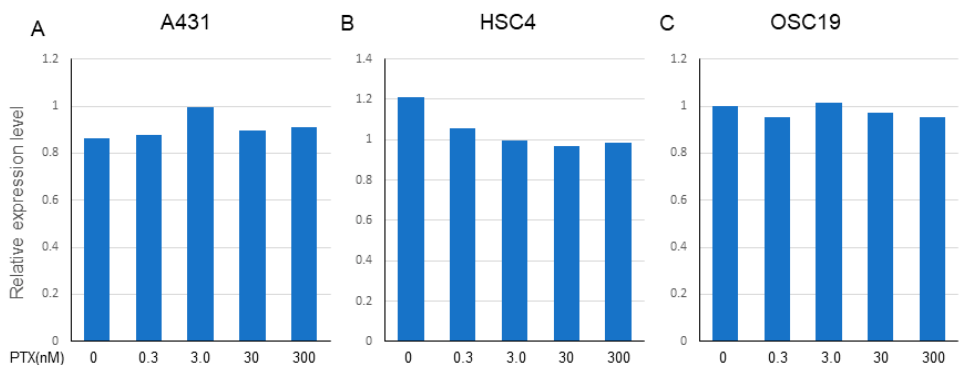
Figure 5. E ff ect of PTX on the expression of EGFR in A431, HSC4, and OSC19. The expression of EGFR on each cell line was determined by TaqMan PCR after treatment with gradient conditions from 0.3 to 300 nM of PTX. ( A ) A431, ( B ) HSC4, ( C ) OSC19. Relative expression level of EGFR (C t value) to the beta-actin as a housekeeping gene is expressed. The data shown is a representative PCR result from two independent experiments with similar results.